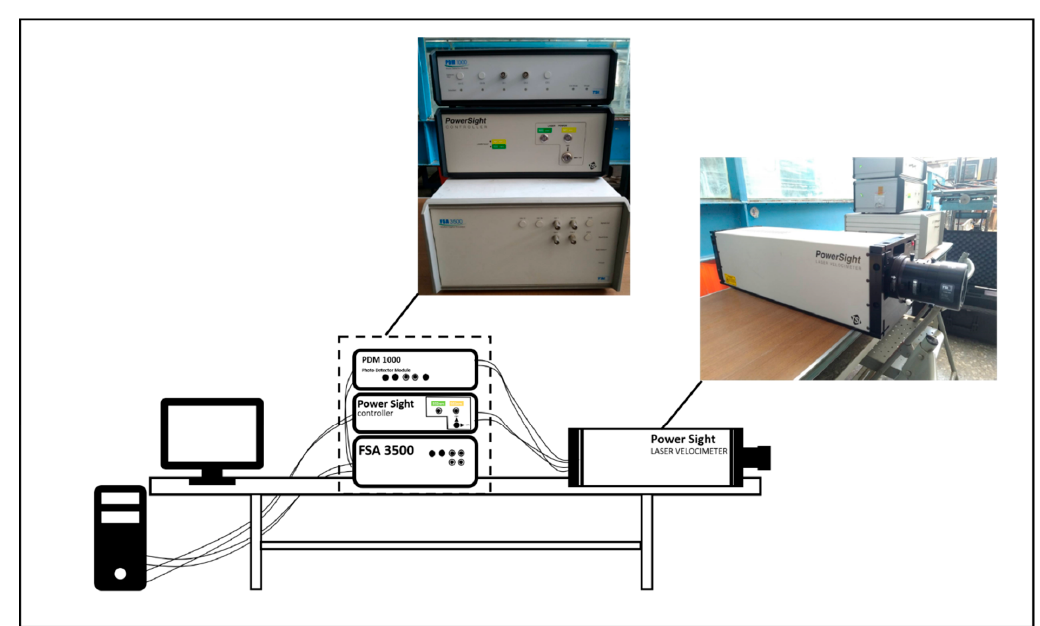
Figure 2. Laser doppler velocimetry (LDV) measurement.